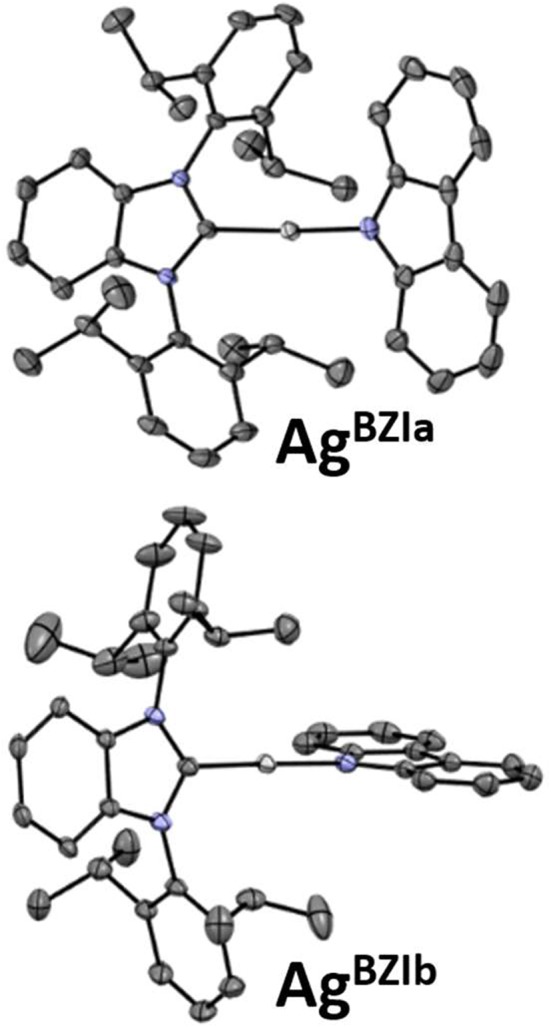
Thermal ellipsoid plots for the conformers of AgBZIa and AgBZIb.